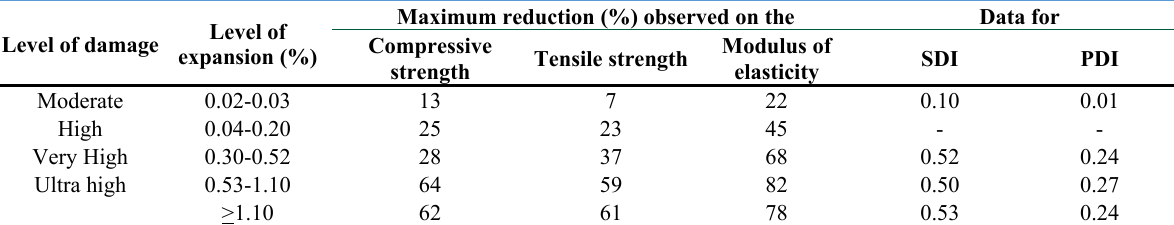
Table 4. Global analyses of DEF damage for concretes without